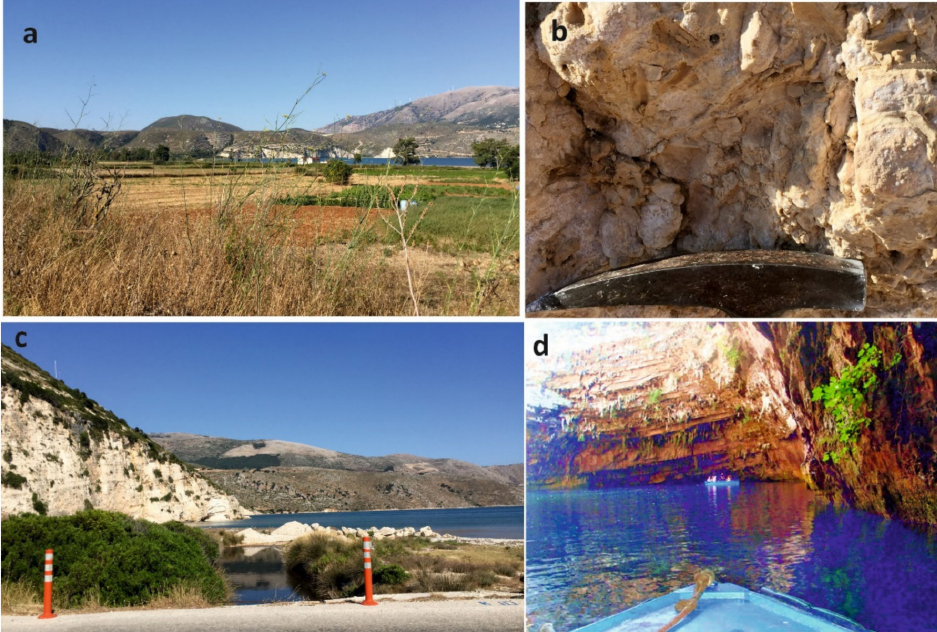
Figure 7. Selected geosites on Kefalonia island, for coding see Figure 4: ( a , c ) Livadi marsh and coastal plain (K14); the limestone outcropping in the area contains numerous rudist fragments ( b ); ( d ) Melissani cave (K03). Photos ( a – c ) courtesy E. Spyrou; ( d ) D.